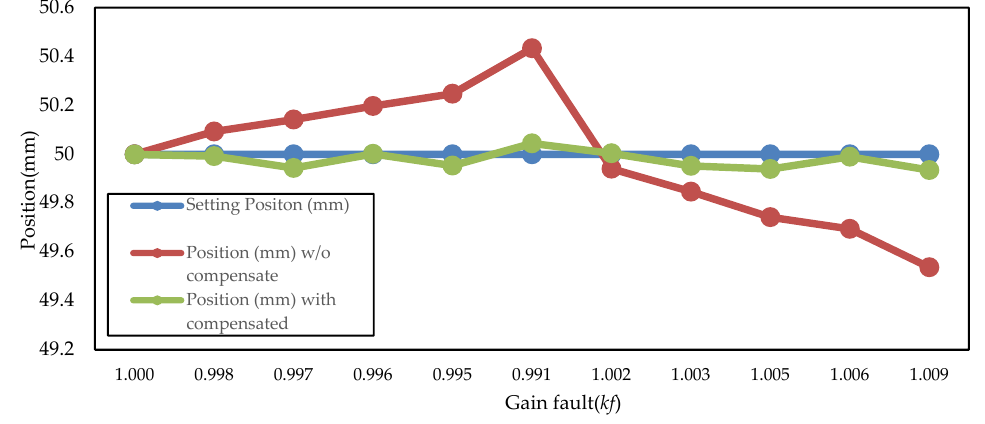
Figure 22. Gain compensation by discrete gain scheduling. Table 4. Gain compensation result for discrete gain scheduling.